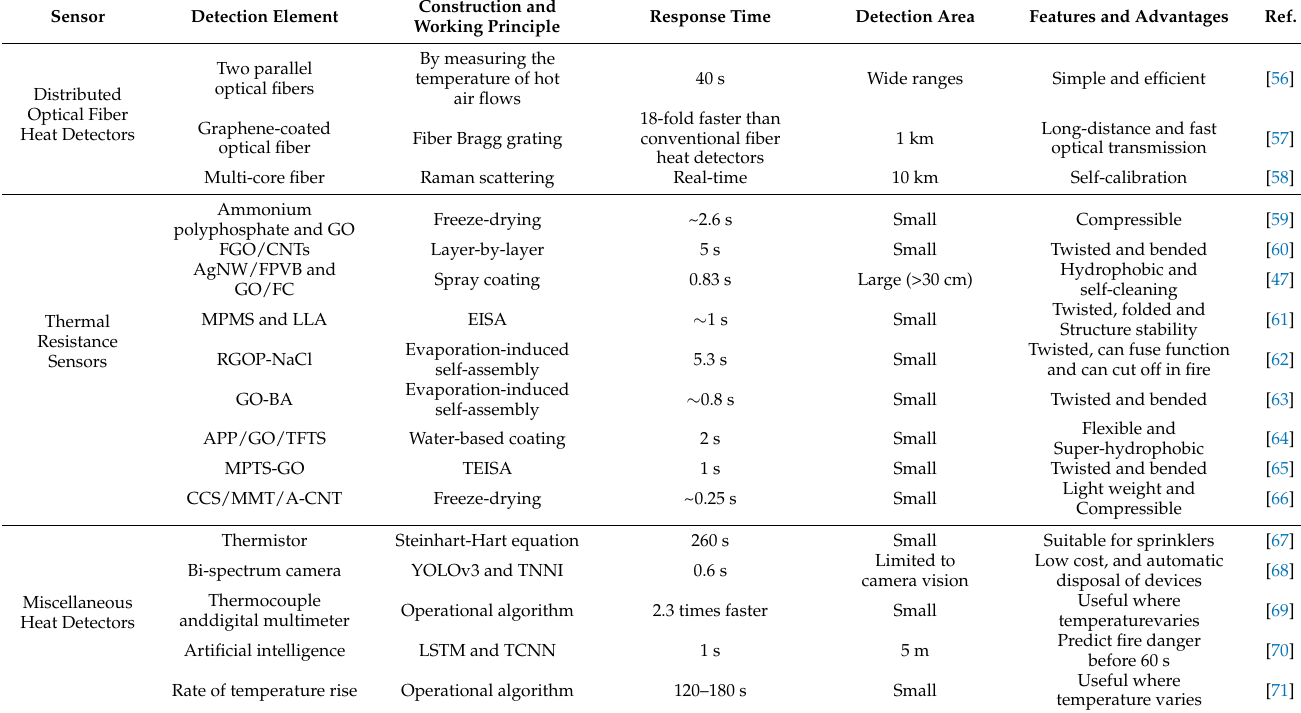
Table 1. Recent developments and comparison of different heat sensors and their